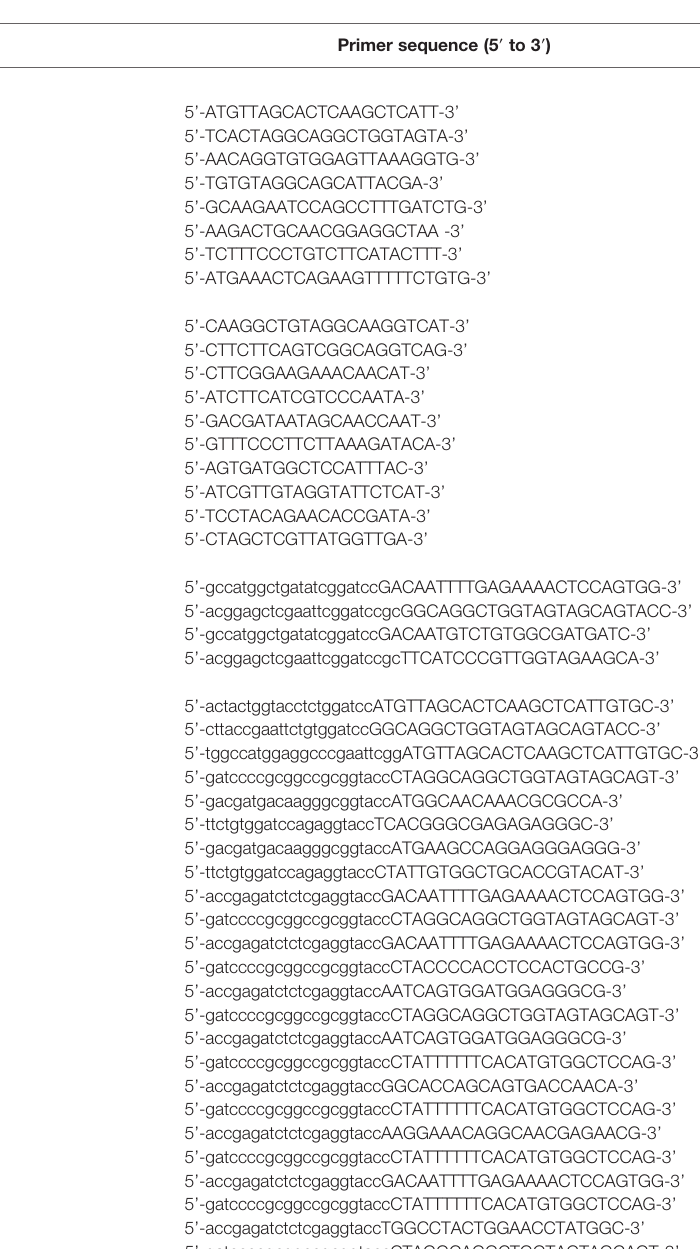
TABLE 1 | Primers used for PCR ampli fi